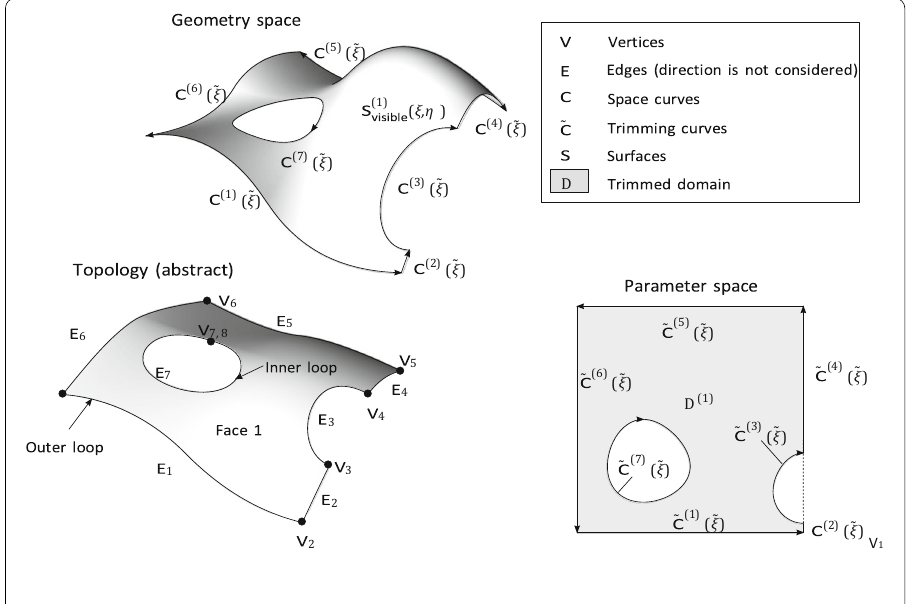
Fig. 2 Example of B-Rep surface (trimmed surface) within Geometry and Parameterspace including its ( ξ , η ) is bounded by the trimming curves ˜ C (˜ ξ ) resp. space curves C (˜ ξ ) within Topology . The surface S (1) visible the parameter resp. geometry space (modified figure from [4])